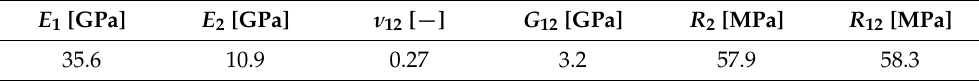
Table 1. Elastic constants of the composite ply material from static